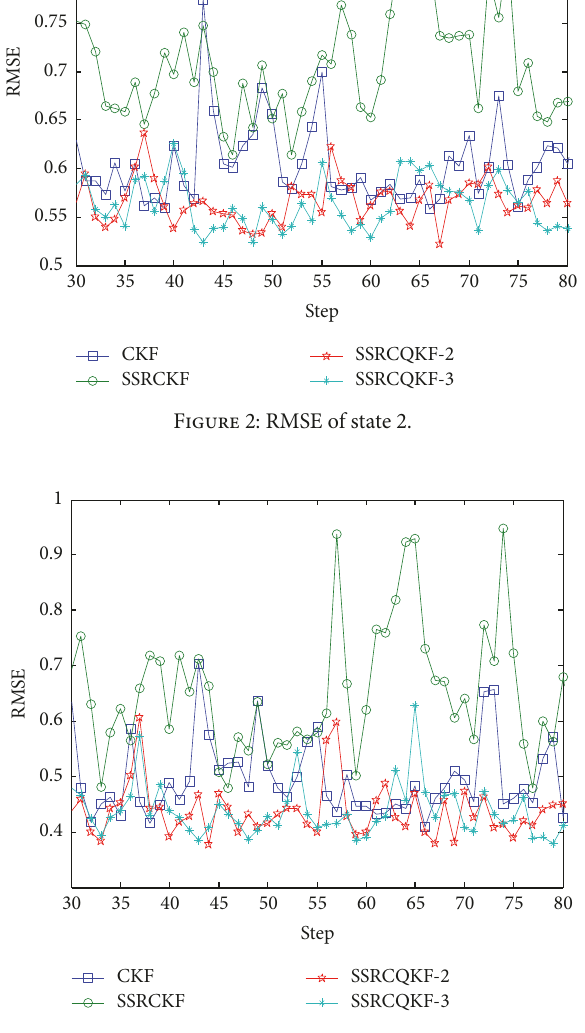
Figure 3: RMSE of state 3.